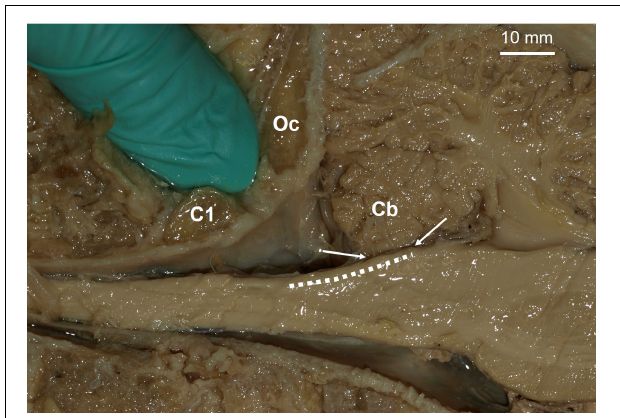
FIGURE 2 | Proposed site for a potential dorsal column nuclei complex somatosensory neural prosthesis. Parasagittal view of a human brainstem and cerebellum (Cb). Dashed line indicates location of dorsal column nuclei complex (DCNc). As brain-machine-interface technology advances, future approaches may incorporate soft nanowire electrode “threads” that would permit stable targeted neural excitation during movement of the brainstem. Arrows indicate the DCNc region covered by the Cb, which can be easily retracted for electrode implantation if required. The gloved finger is inserted in the space proposed for surgical access, i.e. between the 1st cervical segment (C1) and the occipital bone